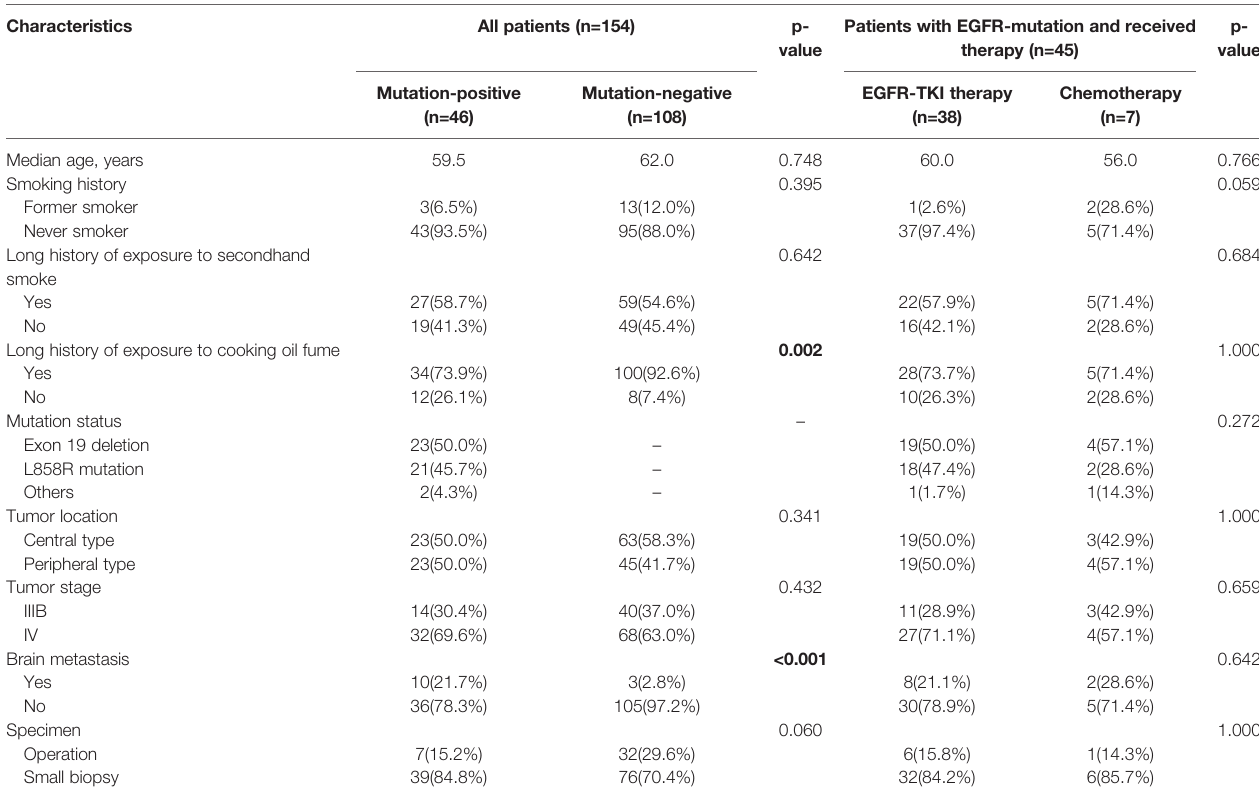
EGFR, epidermal growth factor receptor; TKI, tyrosine-kinase inhibitor. Two-sided P value was derived from Wilcoxon rank sum test for continuous variables and from Chi-square test or Fisher ’ s exact test for categorical variables. Bold values indicated statistical signi fi